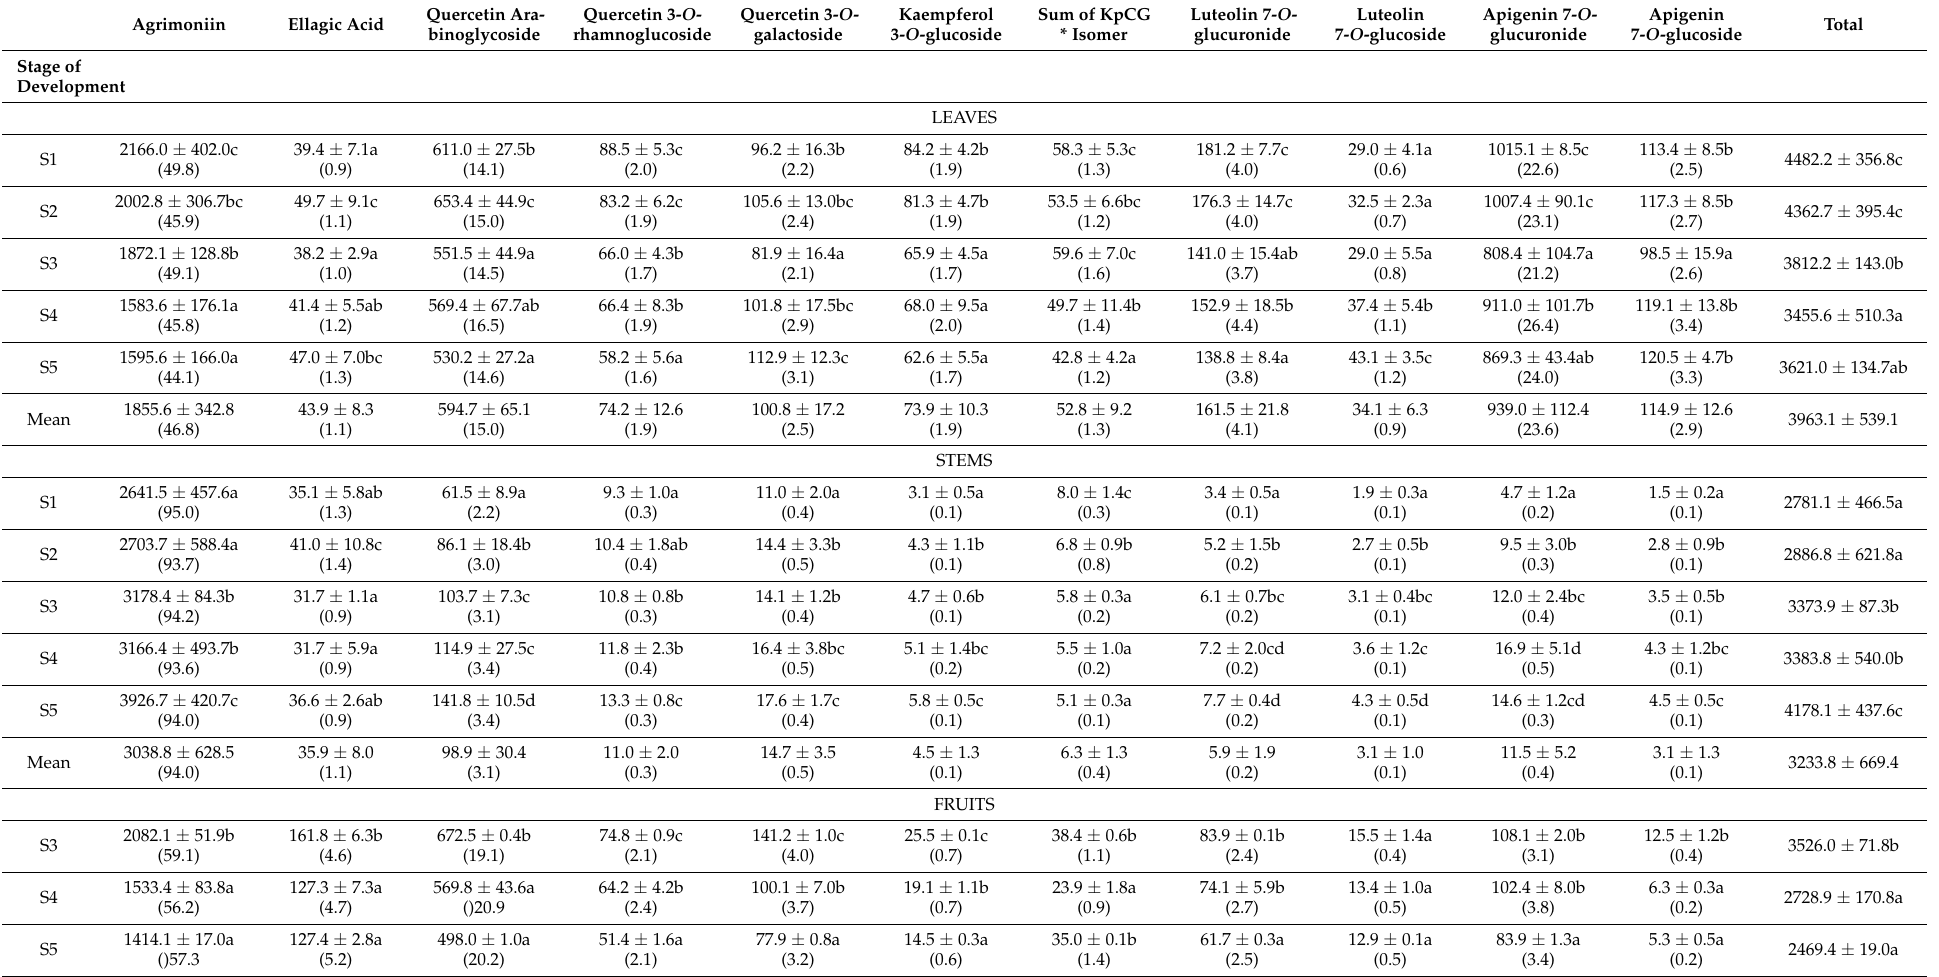
Table 2. The content of polyphenols in the aerial parts (leaves, stems, fruits, seeds, and hypanthia) of A. procera at the main stages of plant development, expressed in mg/100 g of dry weight (DW) * and, in brackets, percentage of each polyphenol related to the total polyphenol